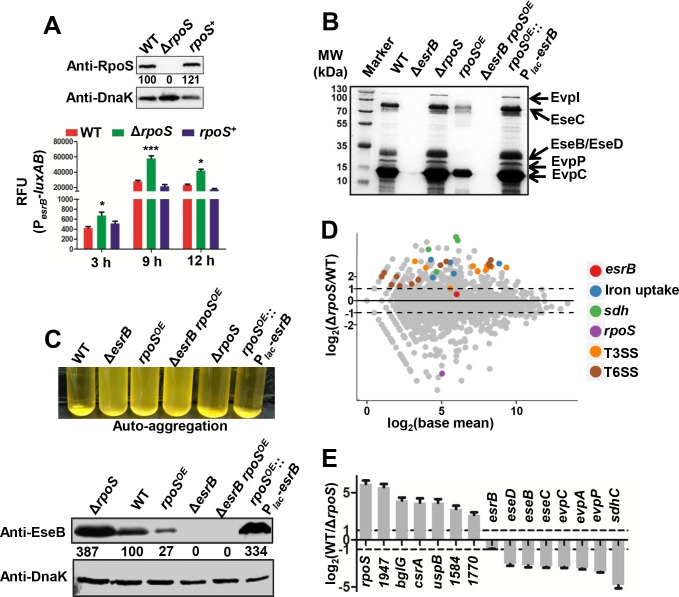
RpoS represses EsrB and T3/T6SS expression.(A) Relative fluorescence units (RFU) of the WT, ΔrpoS and rpoS+ strains grown in DMEM medium at 3, 9, 12 h after inoculation. The results are shown as the mean ± S.D. (n = 3). ***, P < 0.0001; *, P < 0.01 based on student’s t-test. Western blot of RpoS abundance in indicated strains at 9 h is shown on top; DnaK abundance was used as a loading control. The numbers correspond to densitometry measurements. (B) Extracellular protein profiles of WT, ΔesrB, ΔrpoS, rpoSOE(rpoS over-expression), ΔesrB rpoSOE, and rpoSOE:: Plac-esrB (rpoSOE strain harboring constitutively expressing esrB driven from Plac) were separated on SDS-PAGE gels, and specific bands corresponding to T3SS and T6SS proteins [10, 14] are shown. (C) Autoaggregation of the indicated strains statically cultured in DMEM, at 28°C for 24 h. The concentrated supernatants from the same amount of cells were blotted with anti EseB specific antiserum. DnaK was used as the loading control for the blots. (D) MA plots showing differences in the transcriptomes of WT and ΔrpoS cultured in DMEM (n = 3). T3SS, T6SS and iron uptake related genes are highlighted. (E) qRT-PCR assays for the indicated transcripts. The results shown are mean ± S.D. (n = 3). gyrB was used as the internal control.